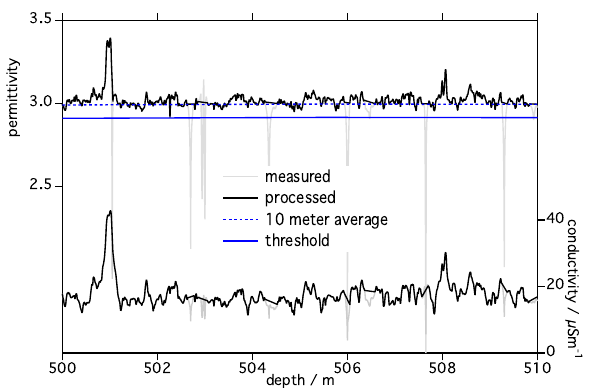
Fig. 1. Example of DEP data processing. The measured DEP record is plotted in grey. Below the firn, the relative permittivity remains just above 3, and sections with permittivity levels below a threshold (blue) defined as a constant value relative to the 10m average value (dashed blue) are excluded from the processed data set (black). In a second step we manually deal with obviously faulty